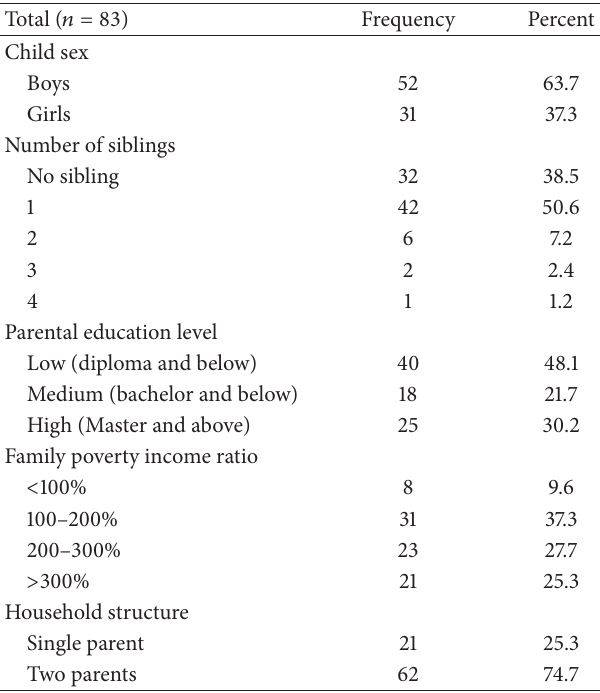
Table 1: General information of the children with